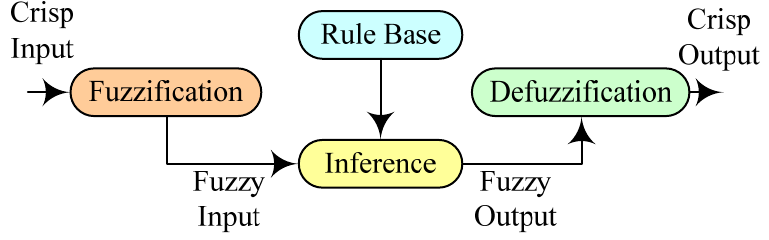
Figure 21. Block representation of FLC-based MPPT.